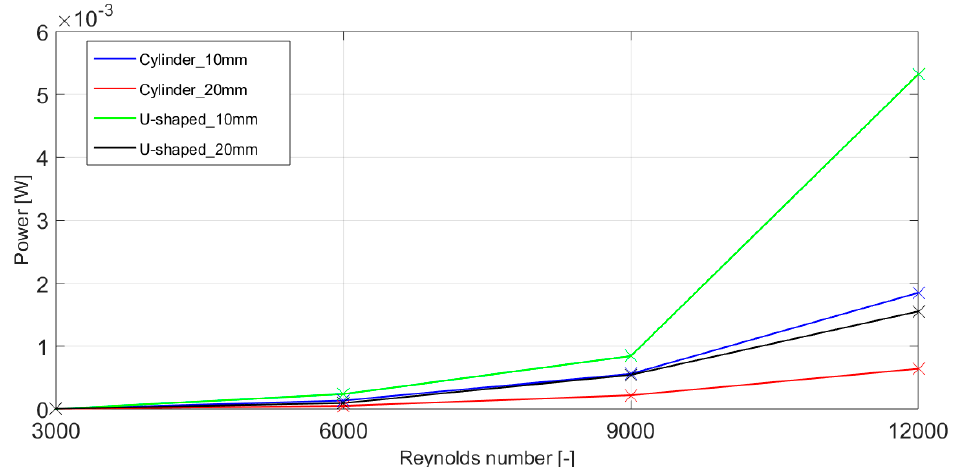
Figure 7. Comparison of the optimal power generated by the proposed four different energy harvesting system geometries.